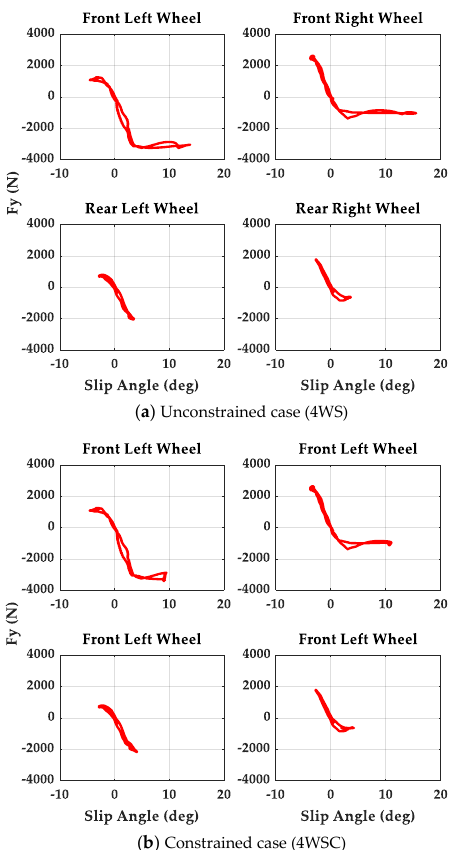
Figure 6. Lateral tire forces with respect to slip angles for unconstrained and constrained cases.